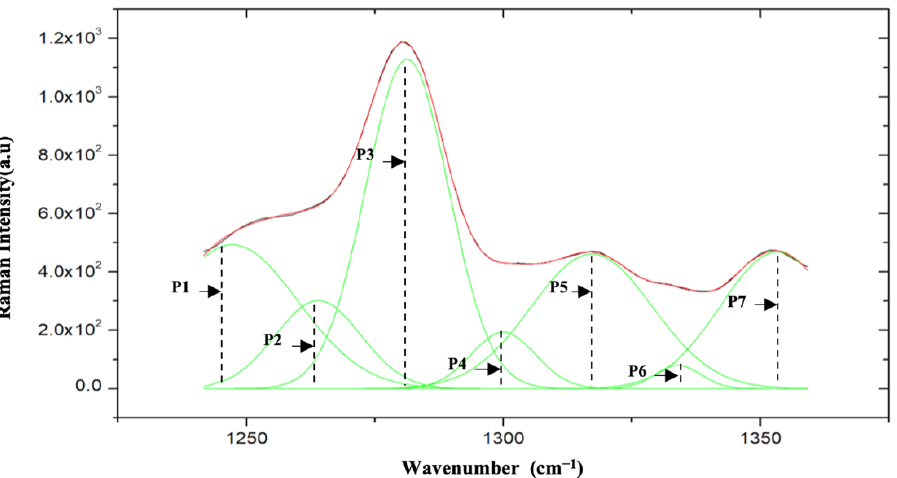
Figure 3. Raman spectra after deconvolution and curve fitting between the range of 1240 cm − 1 to 1360 cm − 1 , where 7 hidden peaks are revealed, labeled as P1-P7.